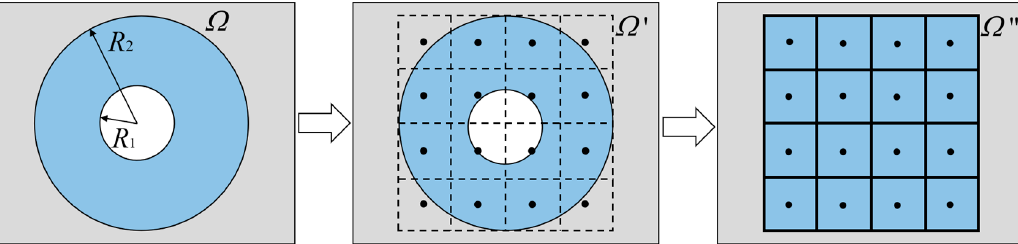
Figure 3. Schematic discretization of an annular meta ‐ structural plane into sixteen square units.